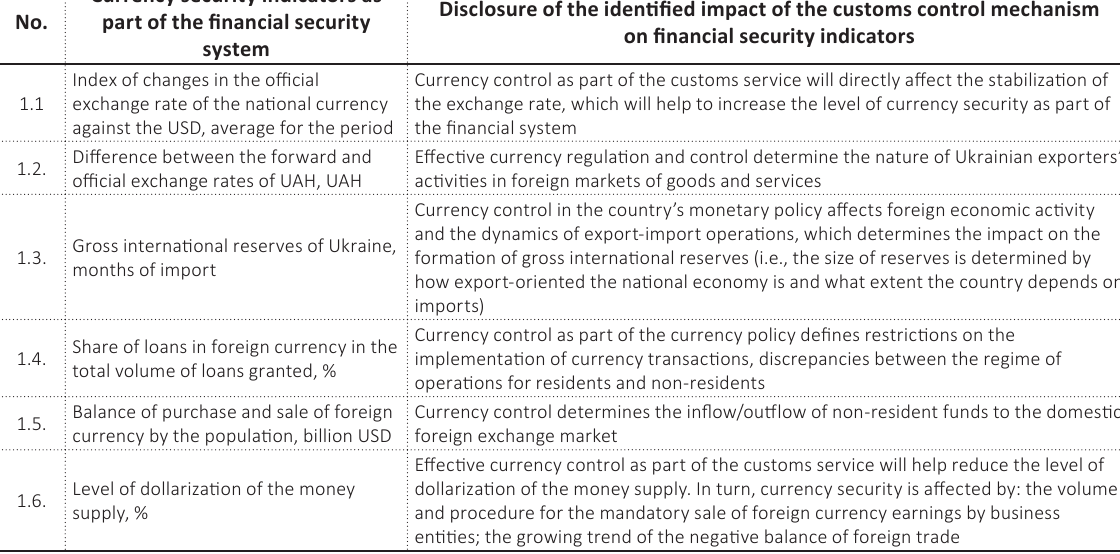
Table 3. Indicators of currency security in the financial security system and the impact of the results of customs (including currency) control on